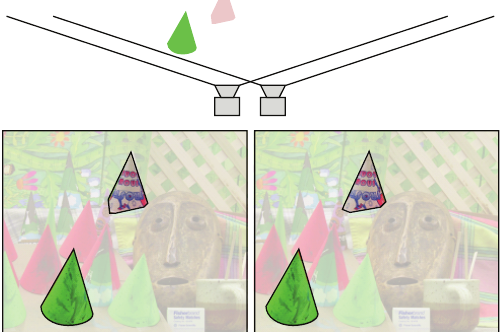
Figure 1: Example image capture for stereo matching. Two cameras physically o ff set capture an image of the same scene. The disparity between the objects in the left and right images infers information about object depth. One foreground and one background object are highlighted for